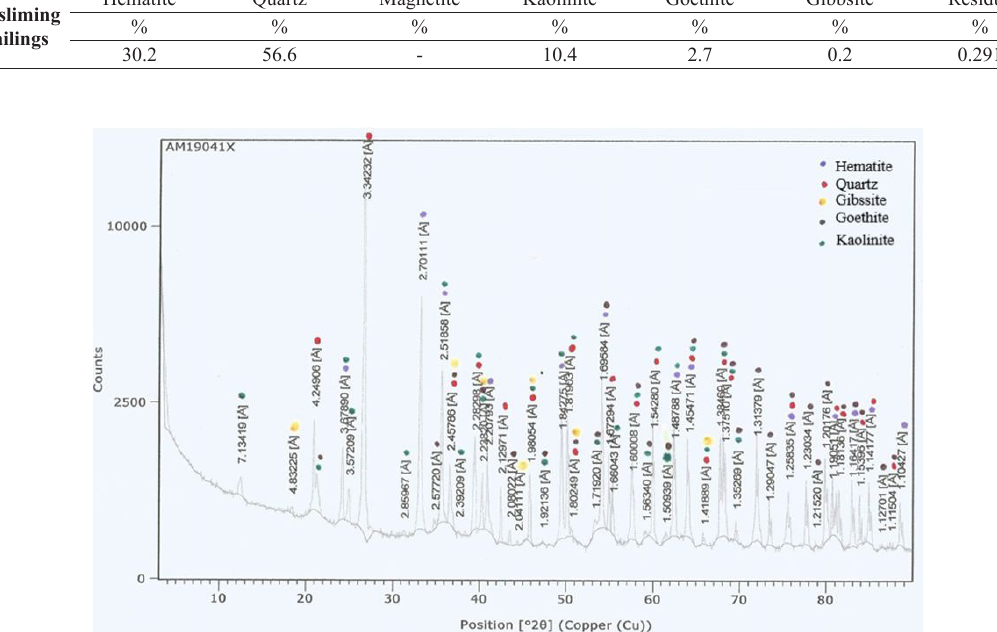
Figure 3. Diffractogram containing the main phases present in the desliming tailings.